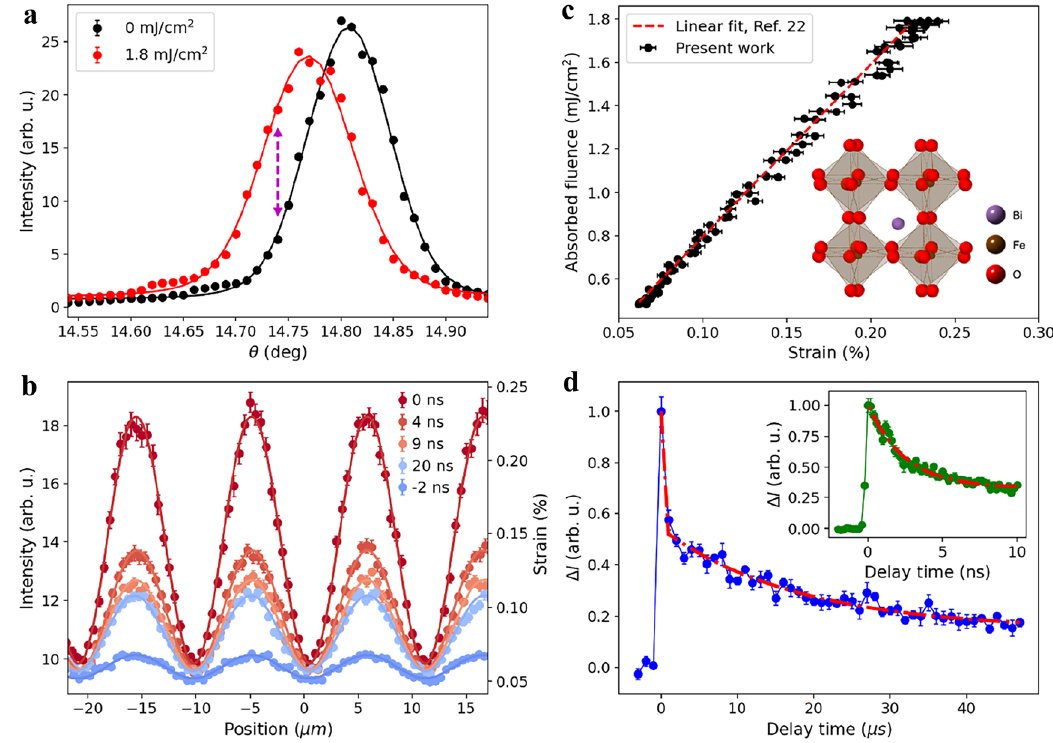
Figure 2. Linear strain dynamics in BFO. ( a ) Shift in the 002 pseudocubic Bragg peak at the TG peak position and t = 0 ns for zero and maximum laser fluence. The dotted arrow indicates the fixed value of θ used for the measurements shown in ( b,d ). ( b ) X-ray intensity and corresponding strain as a function of TG position for several delay times. Solid lines are sinusoidal fits. ( c ) The estimated fluence as a function of the measured strain at 0 ns extracted from ( b ), based on the linear relationship (dashed line) from Ref. 22 . Inset: Perovskite BFO structure showing Bi (purple), O (red), and Fe (brown) atoms. ( d ) Changes in X-ray intensity at the TG peak as a function of time, fit with a bi-exponential decay (red dotted line) with time constants 2.5 ns and 18 μs. Inset: higher resolution delay scan in the first 10 ns. Error bars are described in